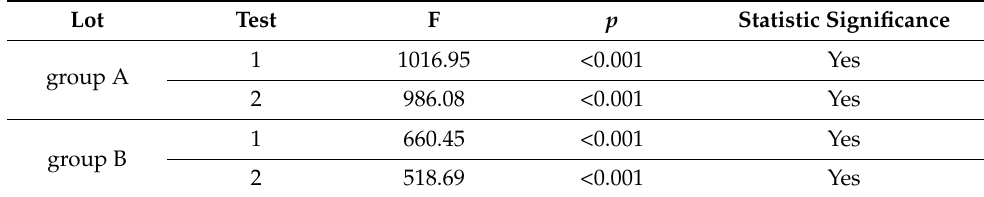
Table 1. ANOVA test 1 and test 2, for group A and B.